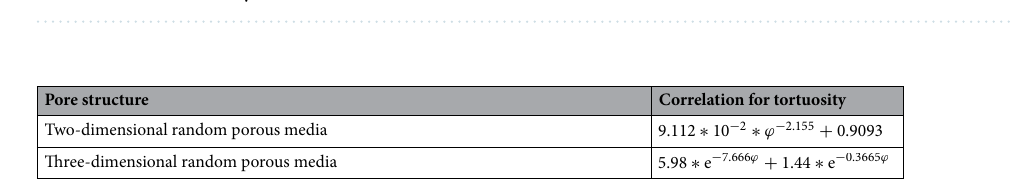
Figure 13. Comparison between tortuosity-porosity correlations from a two-dimensional study and the current three-dimensional study.